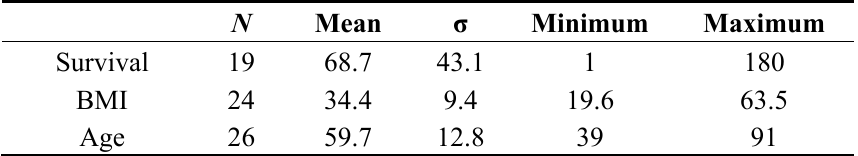
Table 7. In endometrioid cancer group, the cases numbers ( N ), mean value (mean), the maximum value and minimum value on patients’ survival, BMI and age are